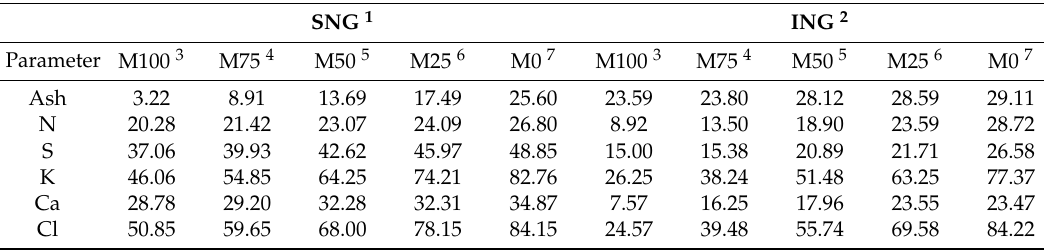
Table A3. Rate of reduction (%) of concentrations of Ash, N, S, K, Ca and Cl from biomass DM to press cake DM achieved in Experiment